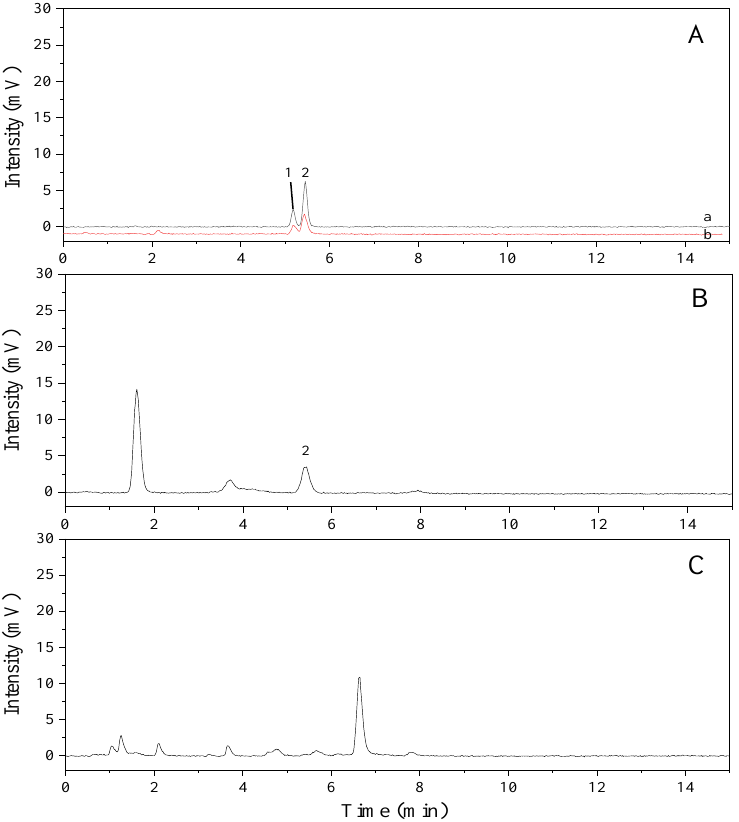
Figure 3. Chromatograms of mixed standards and samples using high-performance liquid chromatography-evaporative light-scattering detection (HPLC-ELSD). ( A ), mixed standard (a, lathosterol standard 0.005 mg/mL and cholesterol standard 0.01 mg/mL; b, lathosterol standard 0.0025 mg/mL and cholesterol standard 0.005 mg/mL). ( B ), Pyropia tenera ; ( C ), perilla seed oil. Peak identification: 1, lathosterol; 2, cholesterol.